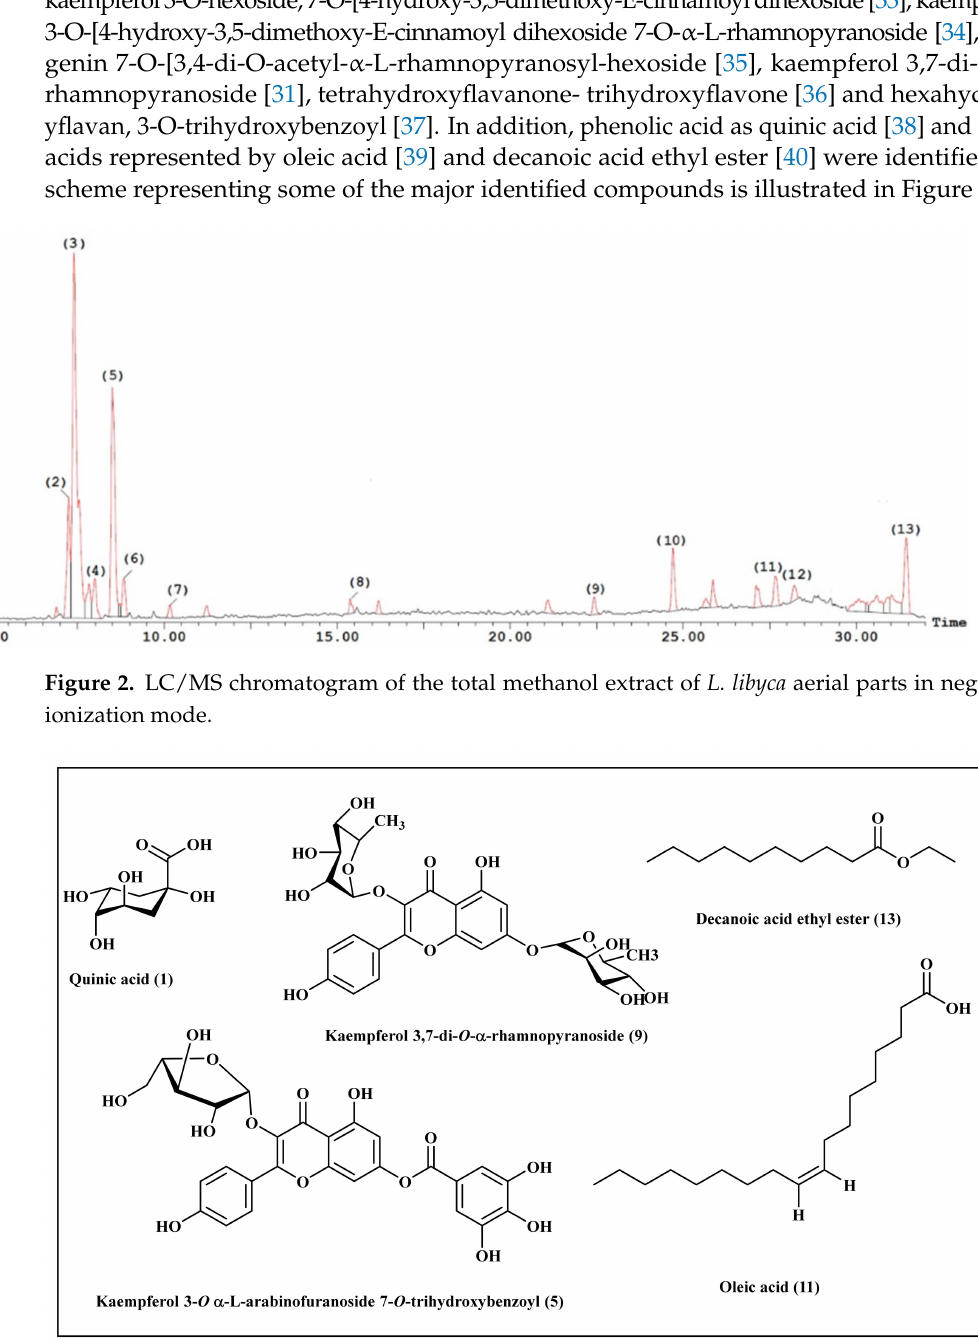
Figure 3. Scheme represents some of the major identified compounds from the methanol extract of the aerial parts of L. libyca